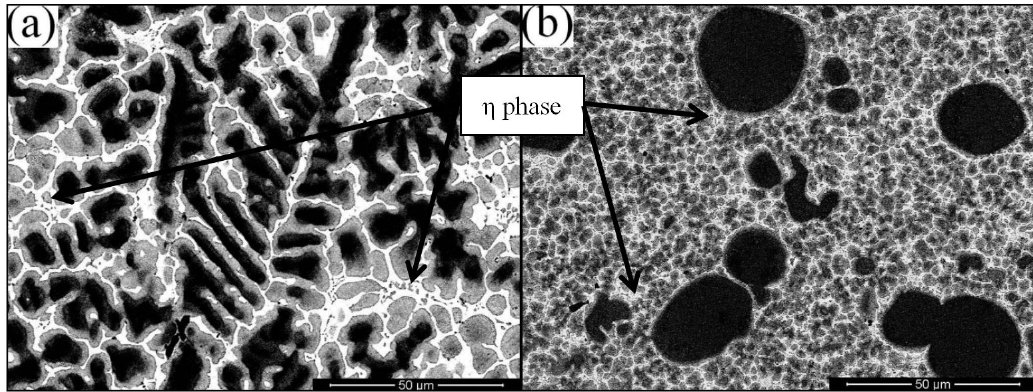
Figure 12. SEM microstructure of HPDC (a) and RDC (b).